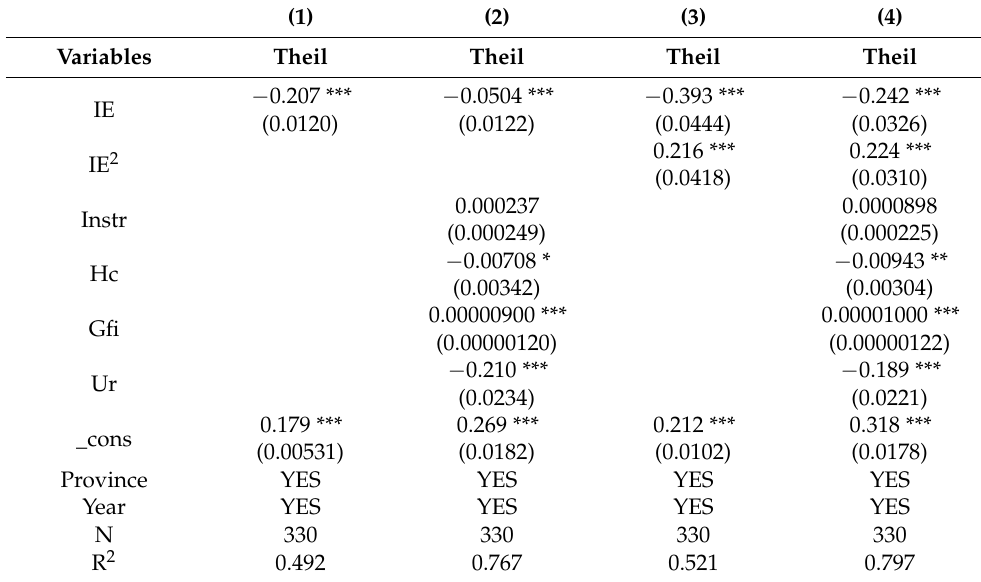
Table 3. Baseline regression results.